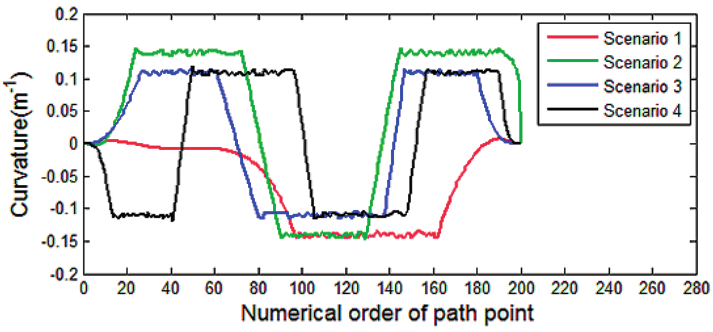
Figure 14. The curvatures of the generated path in different scenarios.